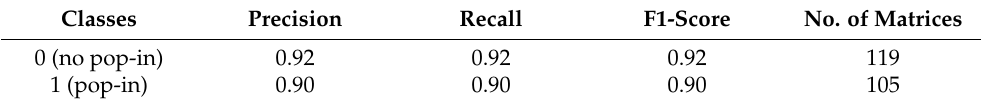
Table 1. Summary of the performance of the CNN model in the validation dataset. Classes Precision Recall F1-Score No. of Matrices 0 (no pop-in) 0.92 0.92